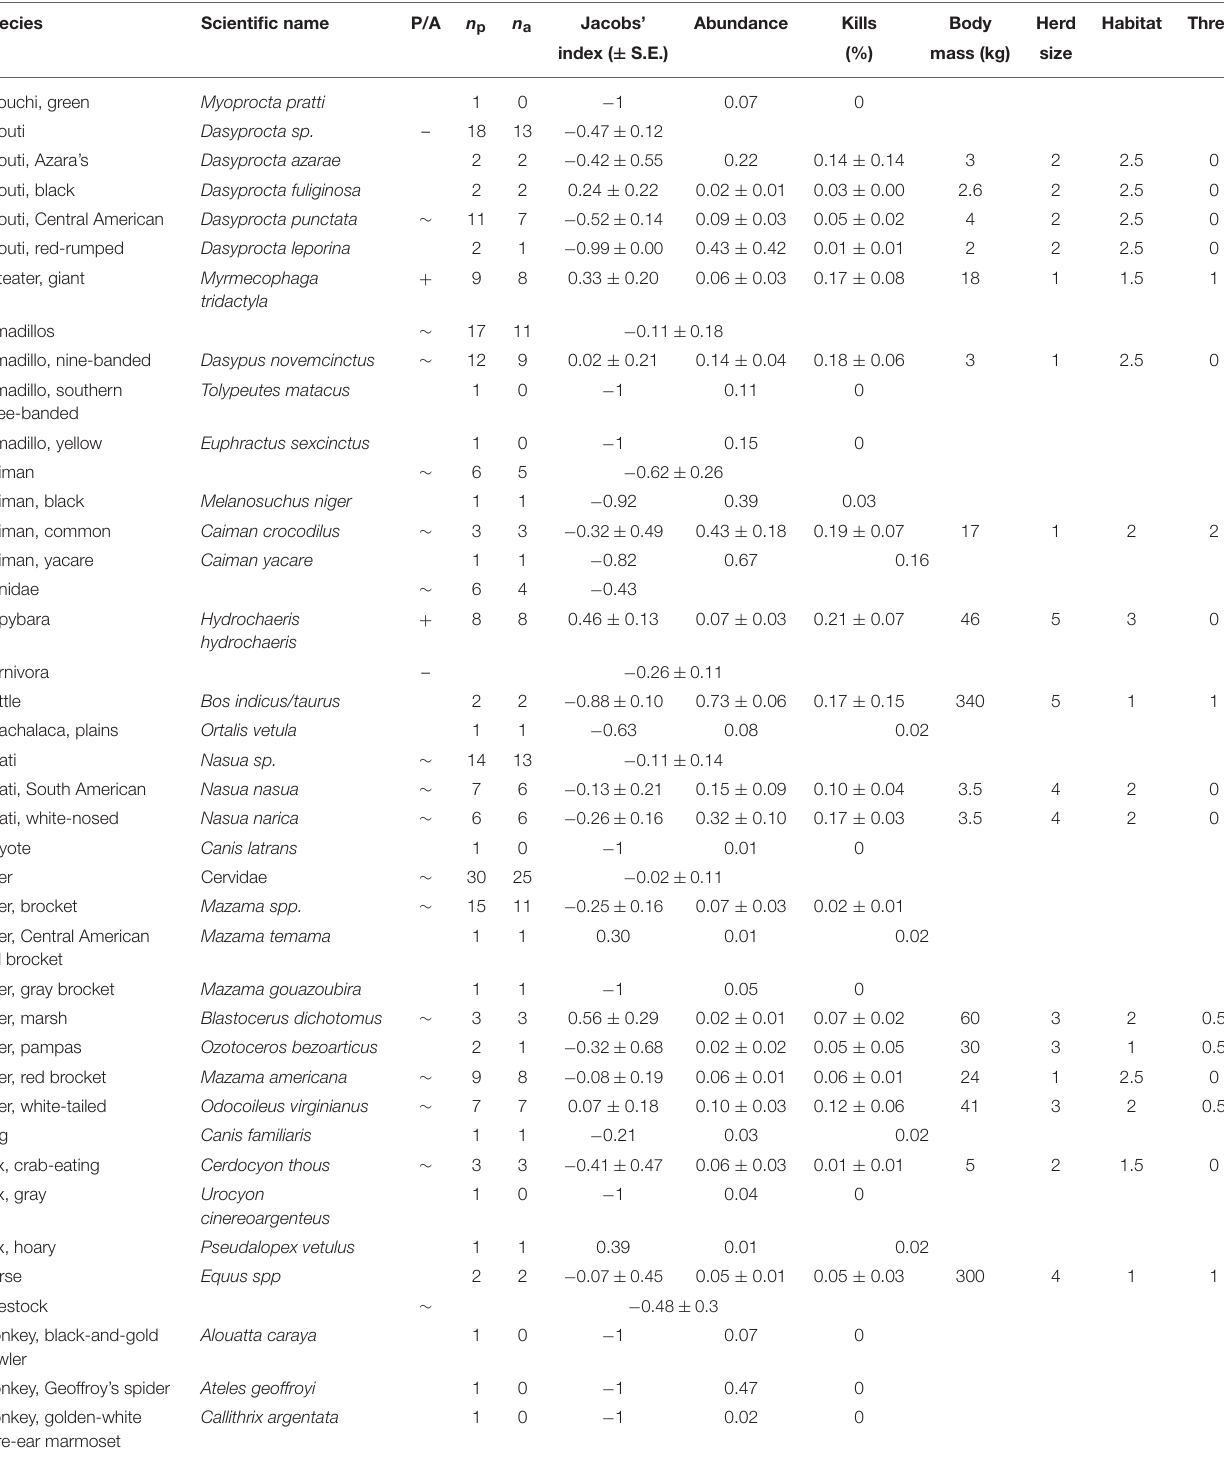
TABLE 2 | Preference status (P/A; where –, denotes significantly avoided; + , significantly preferred; and ∼ , killed in accordance with relative abundance), mean Jacobs’s index value of each jaguar prey species, number of studies recording it as potential prey ( n p ) and actual prey ( n a ), mean percentage abundance and kills of each prey species, body mass (three-quarters of adult female), and categories of herd size, main habitat and potential threat to a jaguar, based on Nowak (1999).